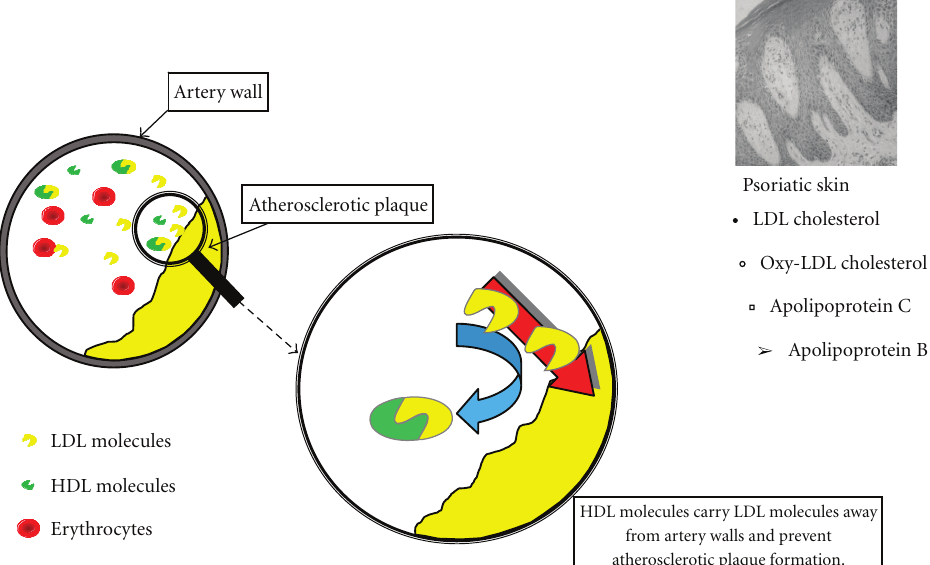
Figure 3: Lipoprotein replacement in circulation from artery walls and peripheral blood into psoriatic skin lesions. Based and modified with permission from figures from [56]. Available from http://www.biolsci.org/v05p0474.htm.